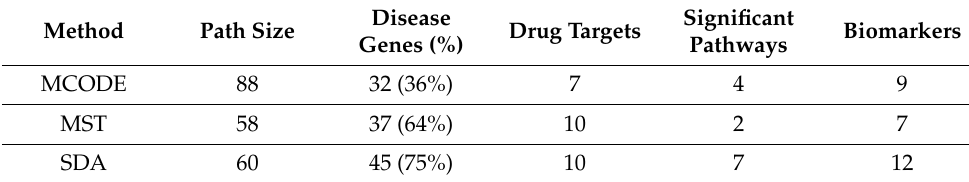
Table 4. Comparing enrichment of significant elements in the